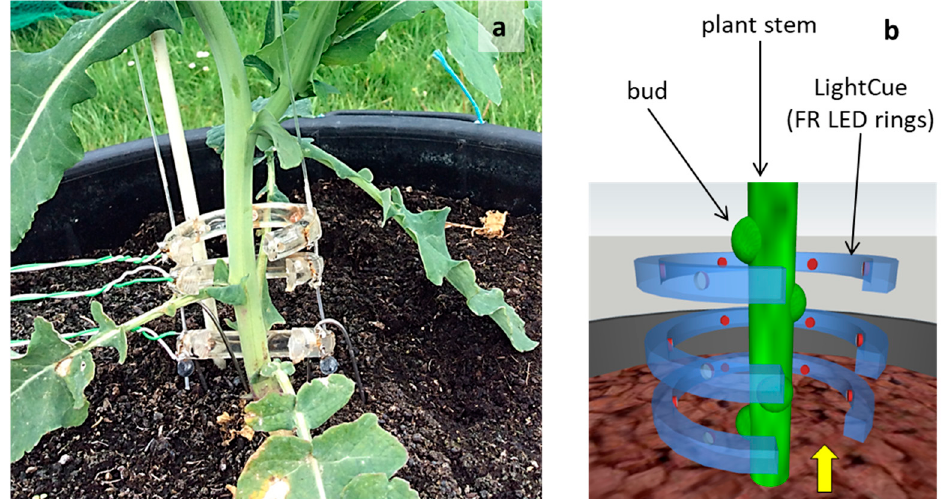
Figure 1. ( a ) Picture showing a plant equipped with LightCue (28 April 2014). ( b ) Diagram focusing on LightCue centered on the buds at the base of an isolated plant. The yellow arrow indicates the direction the spectroradiometer used to measure LED emission is pointing in.